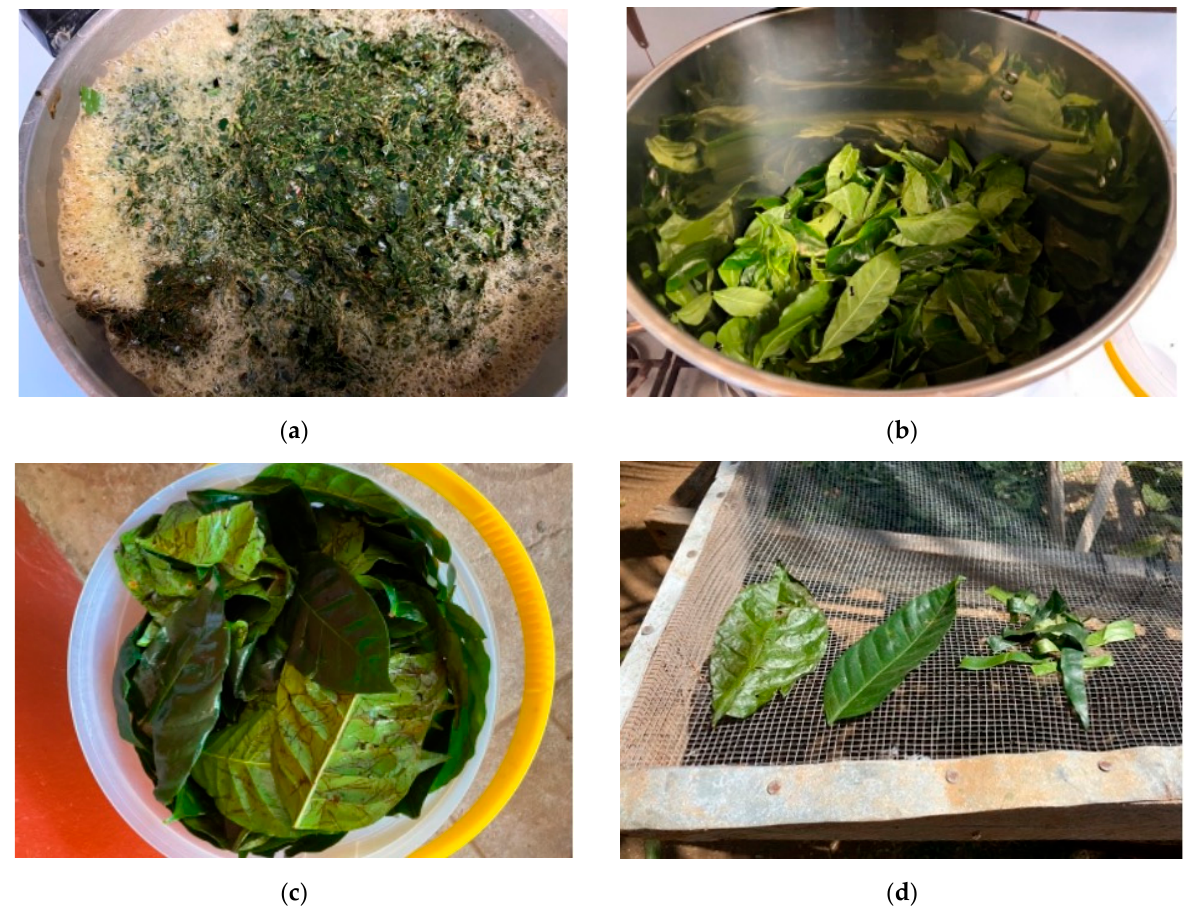
Figure 2. ( a ) Leaves after blending. ( b ) Leaves in the steaming pot. ( c ) Leaves directly after crumbling. ( d ) Crumbled, whole and cut leaves on the drying bed.